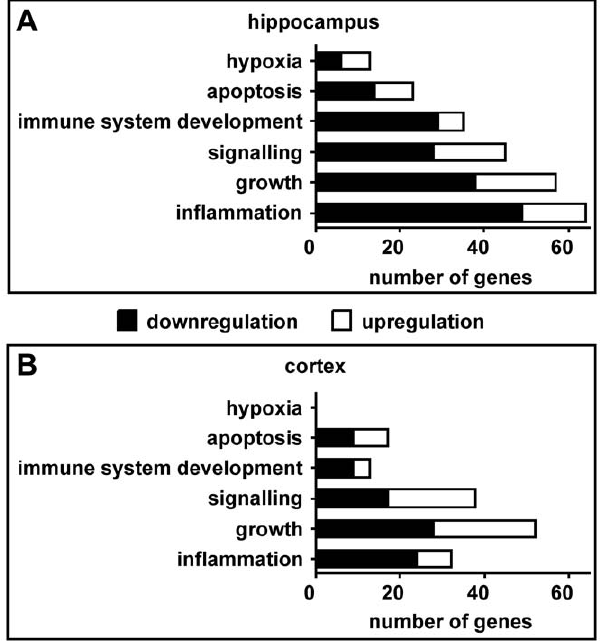
Figure 5. Gene Ontology (GO) analysis of biological processes. Infected and dexamethasone-treated animals were compared with infected and saline-treated animals (ID vs. IS) in the hippocampus (A) and the cortex (B). GO clusters of biological processes were generated by the functional annotation clustering tool of the Database for Annotation, Visualization, and Integrated Discovery (DAVID). These clusters were then assigned to six defined categories.